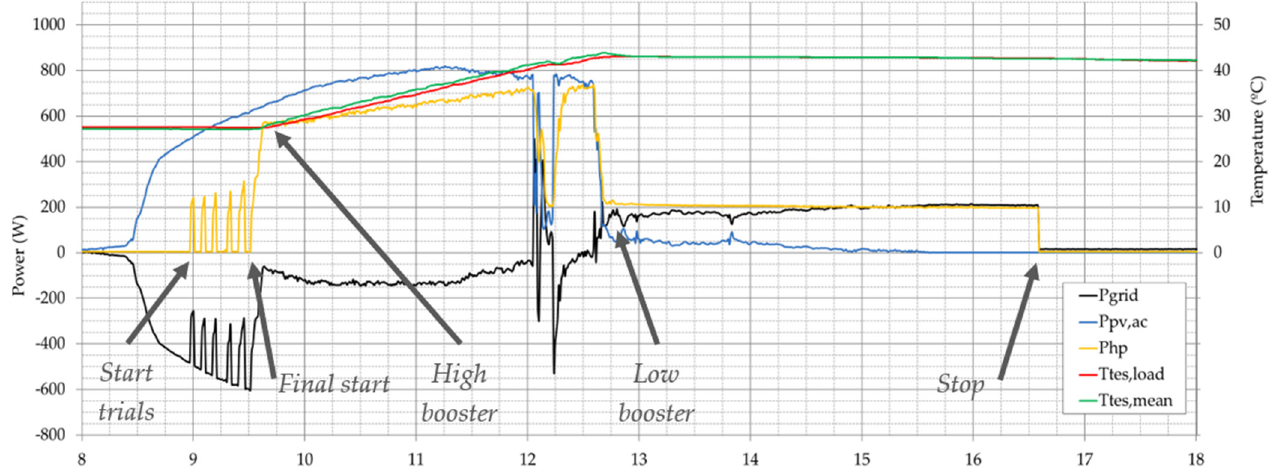
Figure 10. Main system electric power and TES state of charge profiles for the 14 January. The system-level KPIs are turning around compared to the previous low irradiance winter day. The RES increases to 86.9%, boosted by the morning period operation. In the same way, SSR is also improved to a value of 76%, but it is significantly reduced due to non-effective long afternoon operation. The reached SCR is high (73%), based mainly on the morning good control strategy. The SF is 40.9%, limited by HP cooling capacity during the high solar resource morning period.